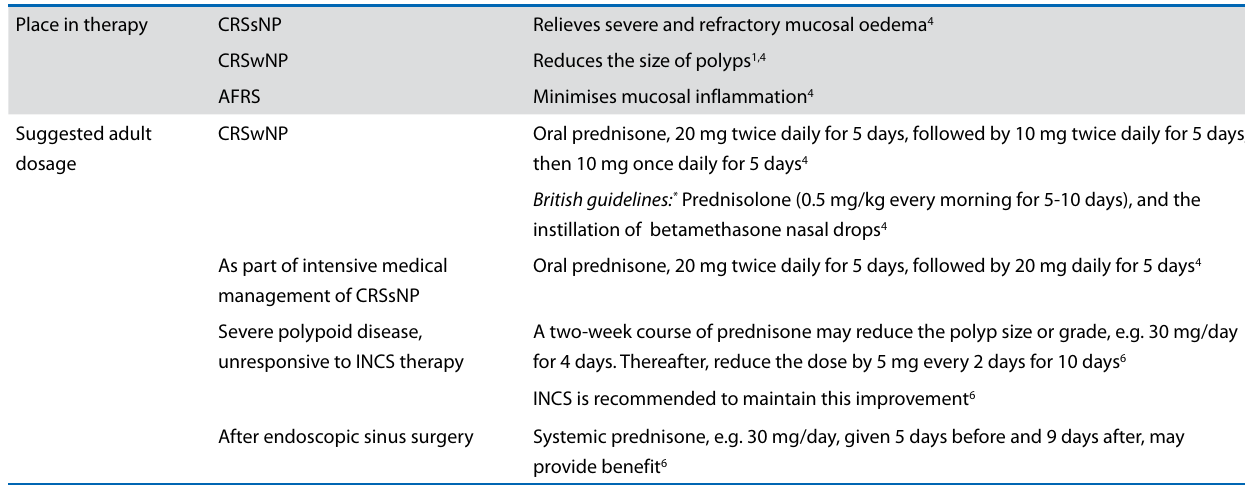
Table V: Place in therapy and suggested dosages of oral corticosteroids Place in